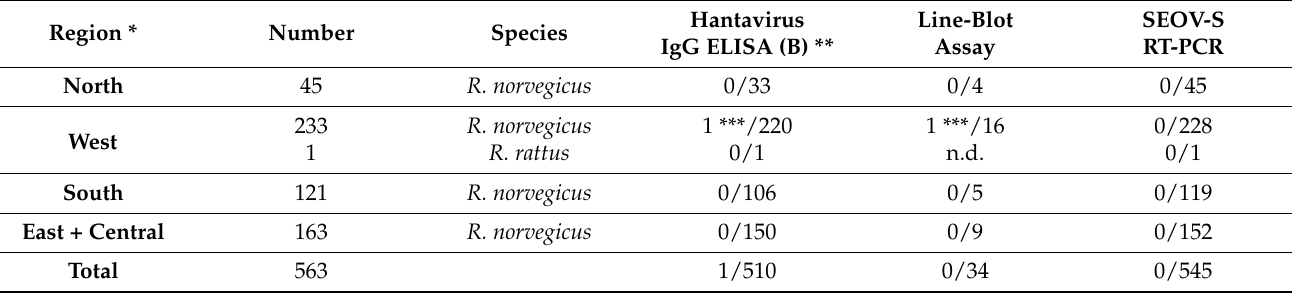
Table 3. Results of serological and conventional RT-PCR analyses of wild rats from different geo- graphic regions in